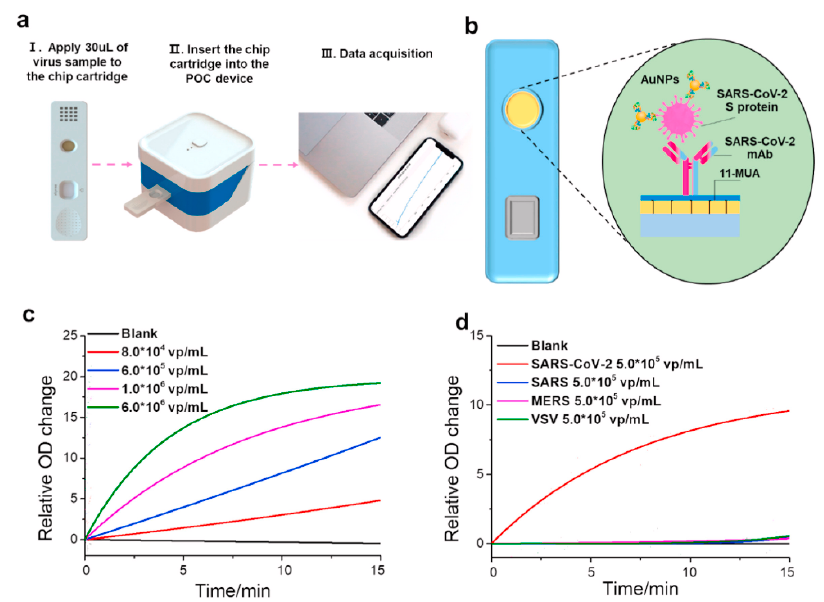
Figure 6. Detection of SARS-CoV-2 pseudovirus with nanoplasmonic sensor chips by a point-of-care device. ( a ) Schematic of nanoplasmonic sensor chip cartridge detecting SARS-CoV-2 pseudovirus with a low-cost handheld point-of-care testing device. ( b ) The illustration shows the detection process of the sensor chip cartridge for specific SARS-CoV-2 detection. ( c ) Dynamic binding curves of virus and antibody interaction with different concentrations of the SARS-CoV-2 pseudovirus over the range 0–6.0 × 106 virus particles (vp)/mL at the resonance wavelength. ( d ) Specificity verification test: Dynamic binding curves of SARS-CoV-2 antibodies interaction with different pseudovirus of SARS-CoV-2, SARS, MERS, and VSV at the concentration of 5.0 × 105 vp/mL. Reprinted with permission obtained from [73] .